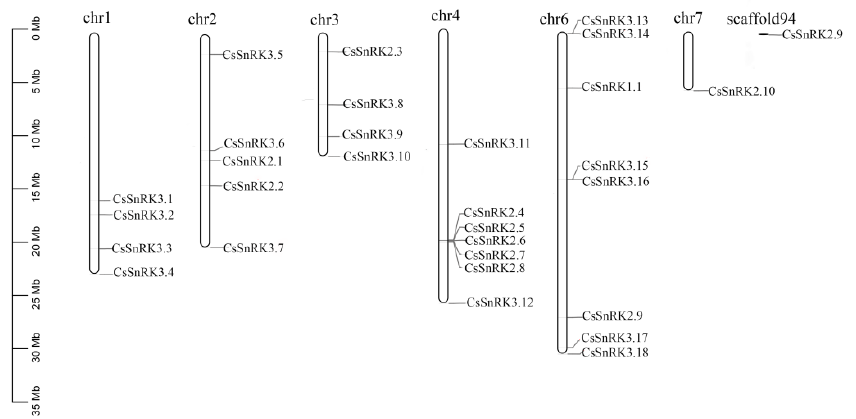
Figure 3. Chromosomal locations of CsSnRK genes. The length of chromosomes can be estimated using the scale on the